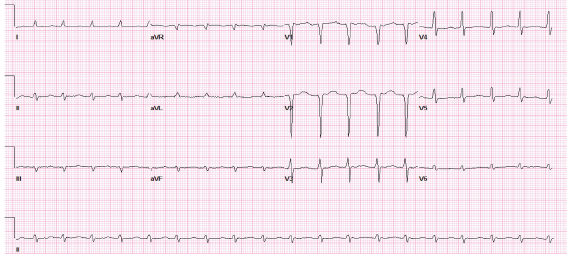
Figure 4: Atrial fibrillation with fairly regular R-R intervals (ventricular rate 113bpm) and slower rate while on beta-blocker. The QRS morphology and voltages remain unchanged from prior